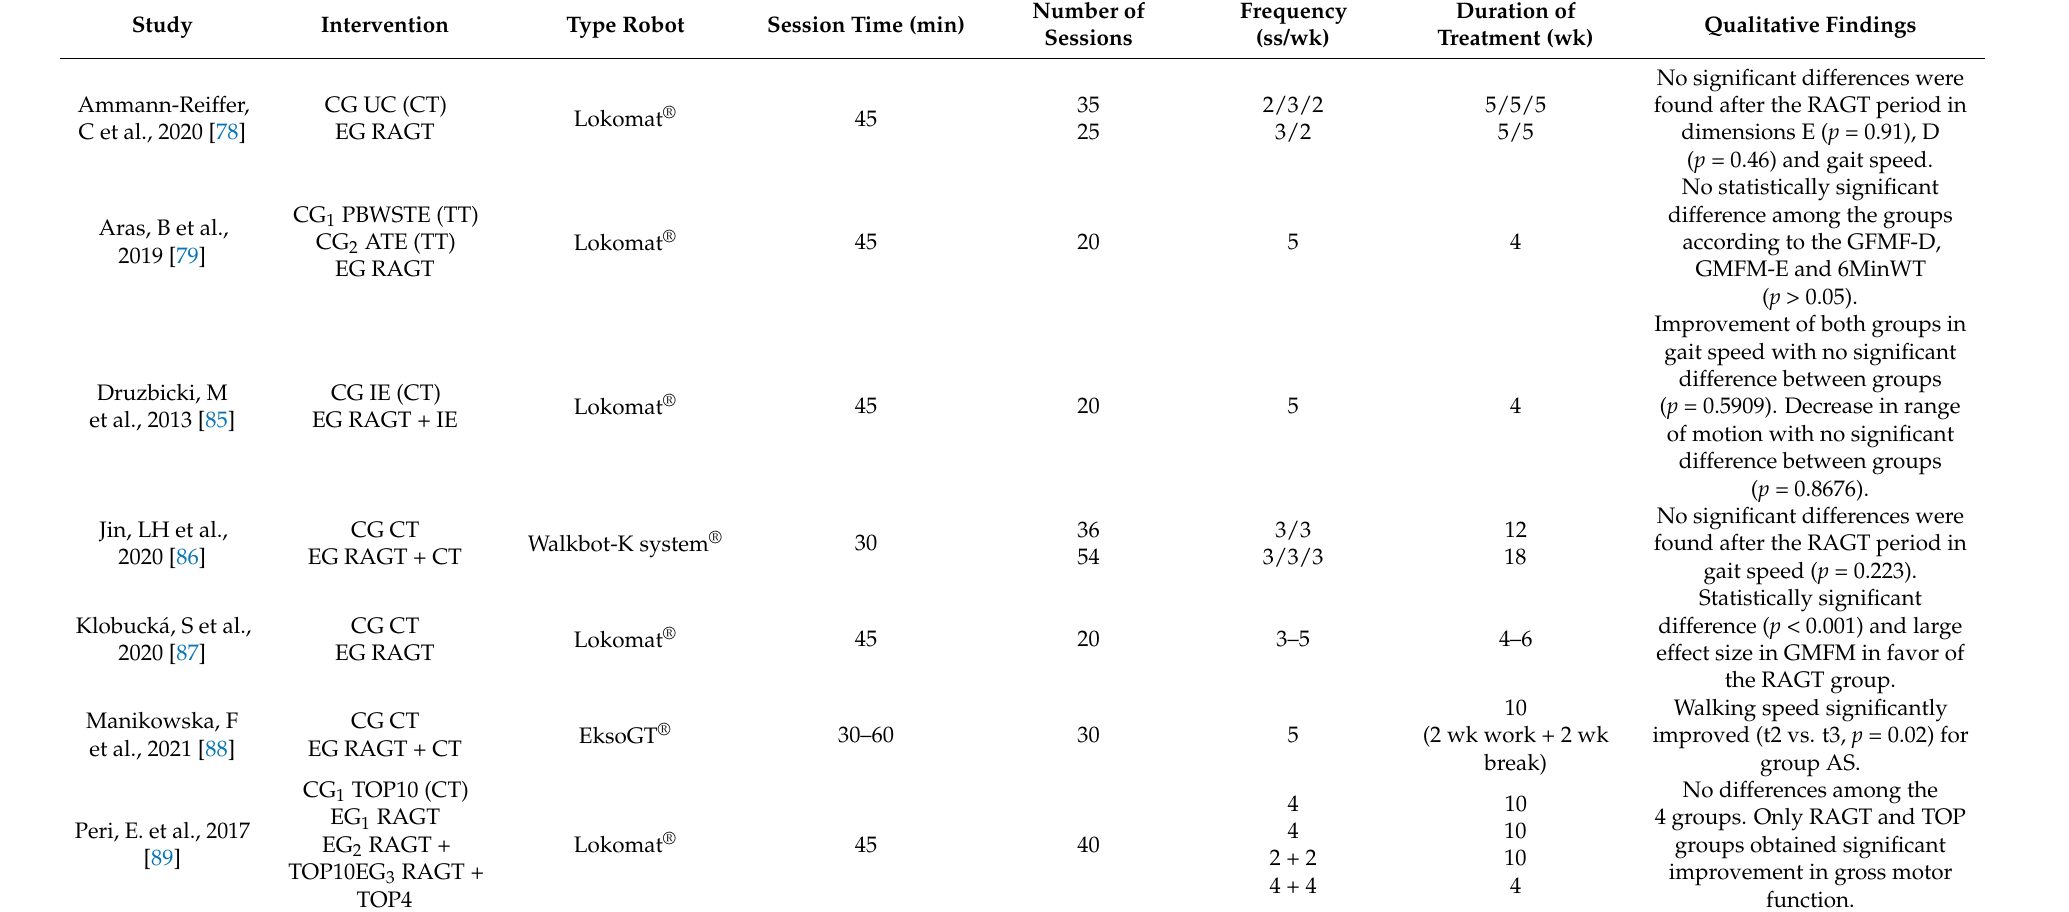
Table 3. Characteristics of the studies included in the systematic review and